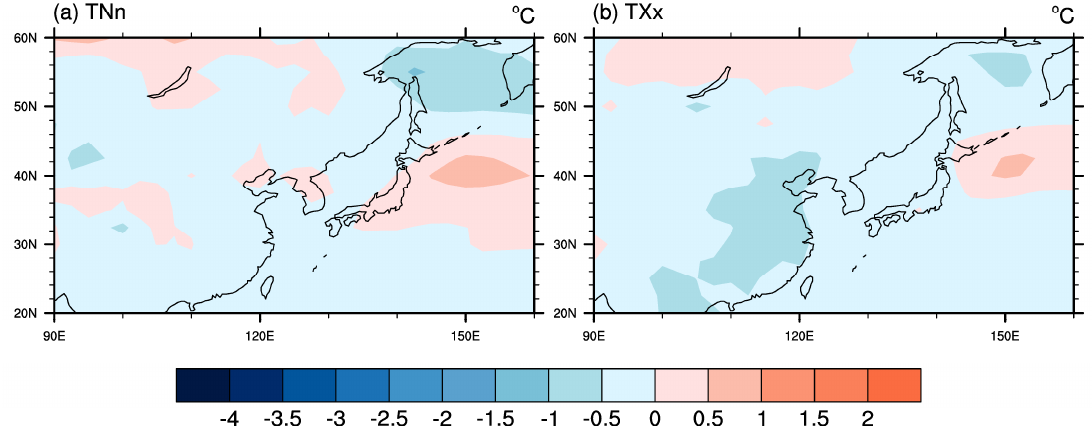
Figure 11. Geographical distribution of the differences in extreme temperature indices between G4cdnc and RCP4.5 for termination period over East Asia. The distributions show the difference in ( a ) TNn and ( b ) TXx. The multi‐model mean results are shown, excluding the MIROC‐ESM model.